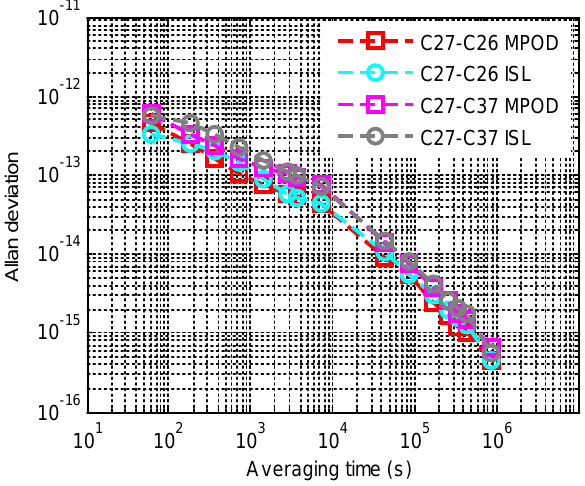
Figure 4. The noise character of relative clock deviations.